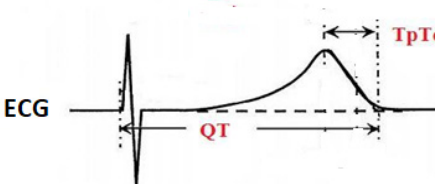
Figure 1. Method of measuring QT and TpTe intervals in ECG. QT—the total repolarization period, TpTe (Tpeak–Tend)—the late repolarization period. Authors’ source .